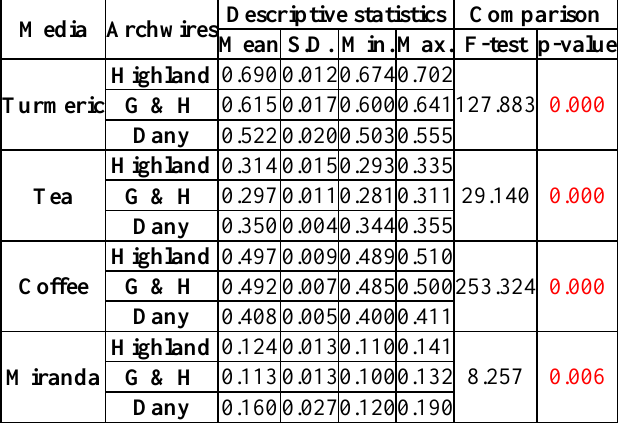
Table 1: Descriptive statistics and comparison of the degree of color absorption after 7 days of